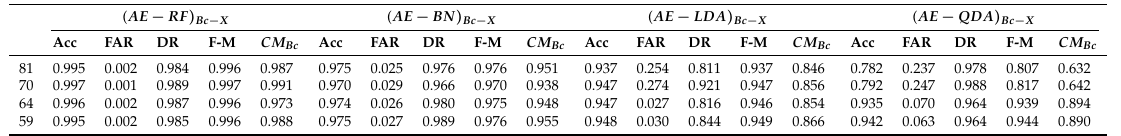
Table 9. Performance evaluation of the proposed framework in binary classification using AE.